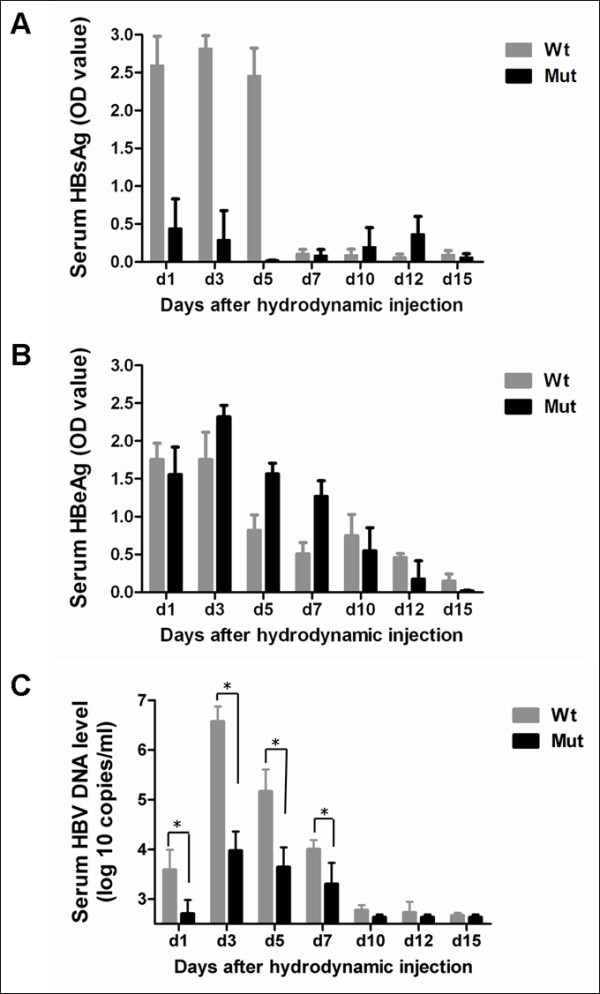
Time-dependent HBV antigen and HBV DNA expression in mice serum after hydrodynamic transfection in vivo. Mice were injected with 10μg pHBV4.1 (Wt) or pHBV rtA181T/sW172* (Mut) respectively. At different time points, HBsAg (A) and HBeAg (B) in the serum were measured by ELISA, and HBV DNA (C) in the serum were detected by quantitative real-time PCR. The mean HBsAg, HBeAg and DNA levels plus standard deviation (indicated by error bars) from three independent analyses are shown (* P<0.001).